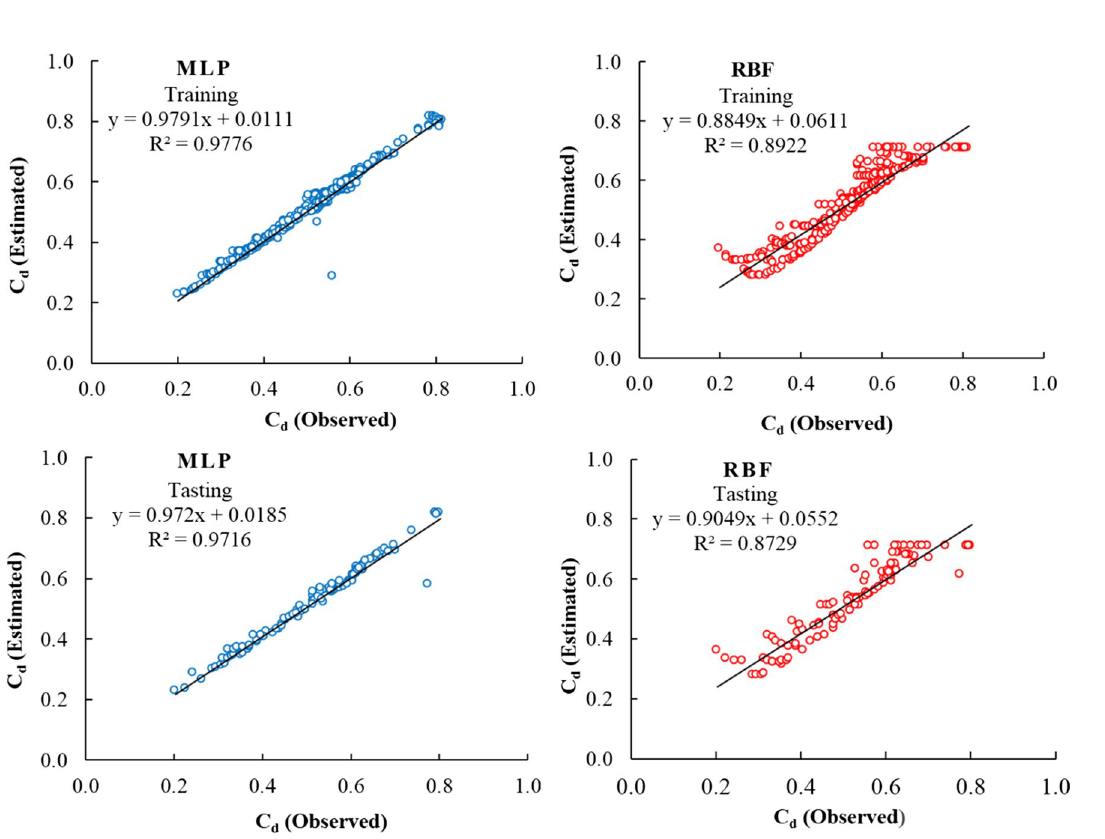
Table 3 The evaluation of the accuracy of the artificial neural networks model in estimating the C d